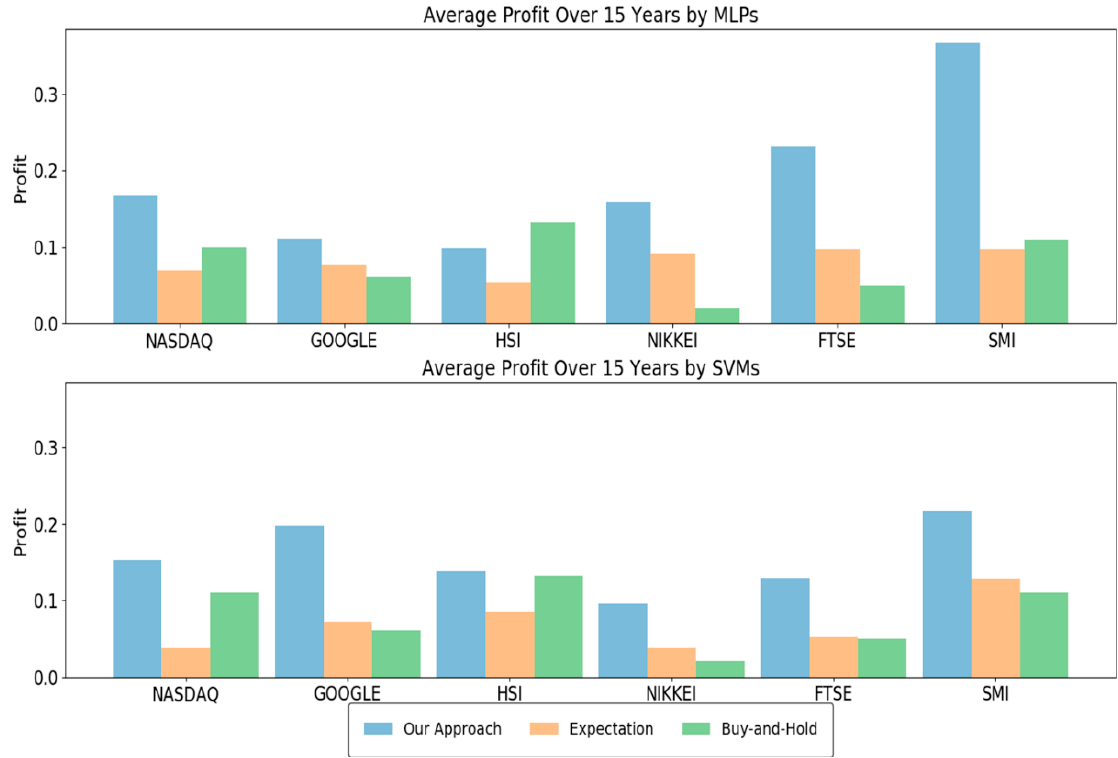
Figure 6. Average profit comparison over 15 years.